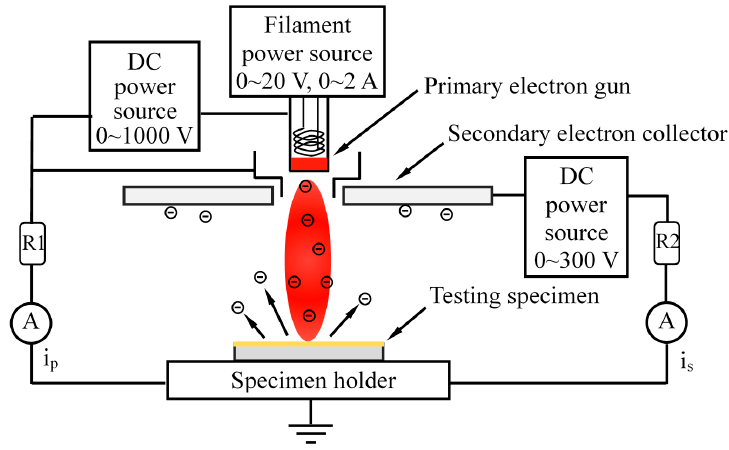
Figure 1. Schematic drawing of the secondary electron emission (SEE) testing system.